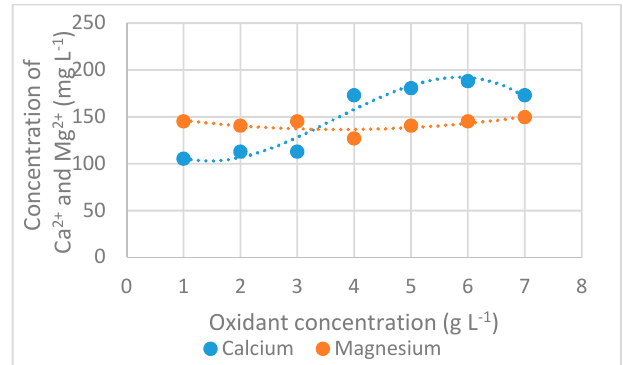
Figure 6. Effect of hydrogen peroxide oxidation on the concentration of calcium and magnesium.